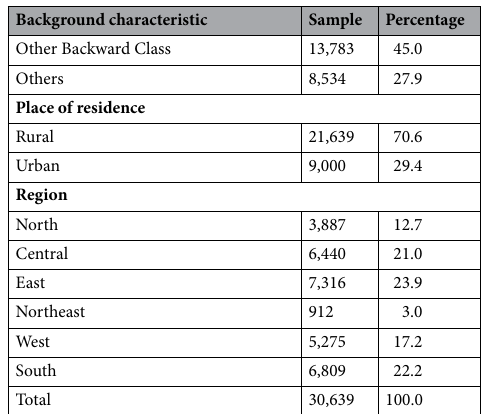
Table 1. Socio-demographic profile of older adults in India. *The sample may differ due to missing cases; ADL: Activities of Daily Living; IADL: Instrumental Activities of Daily Living.